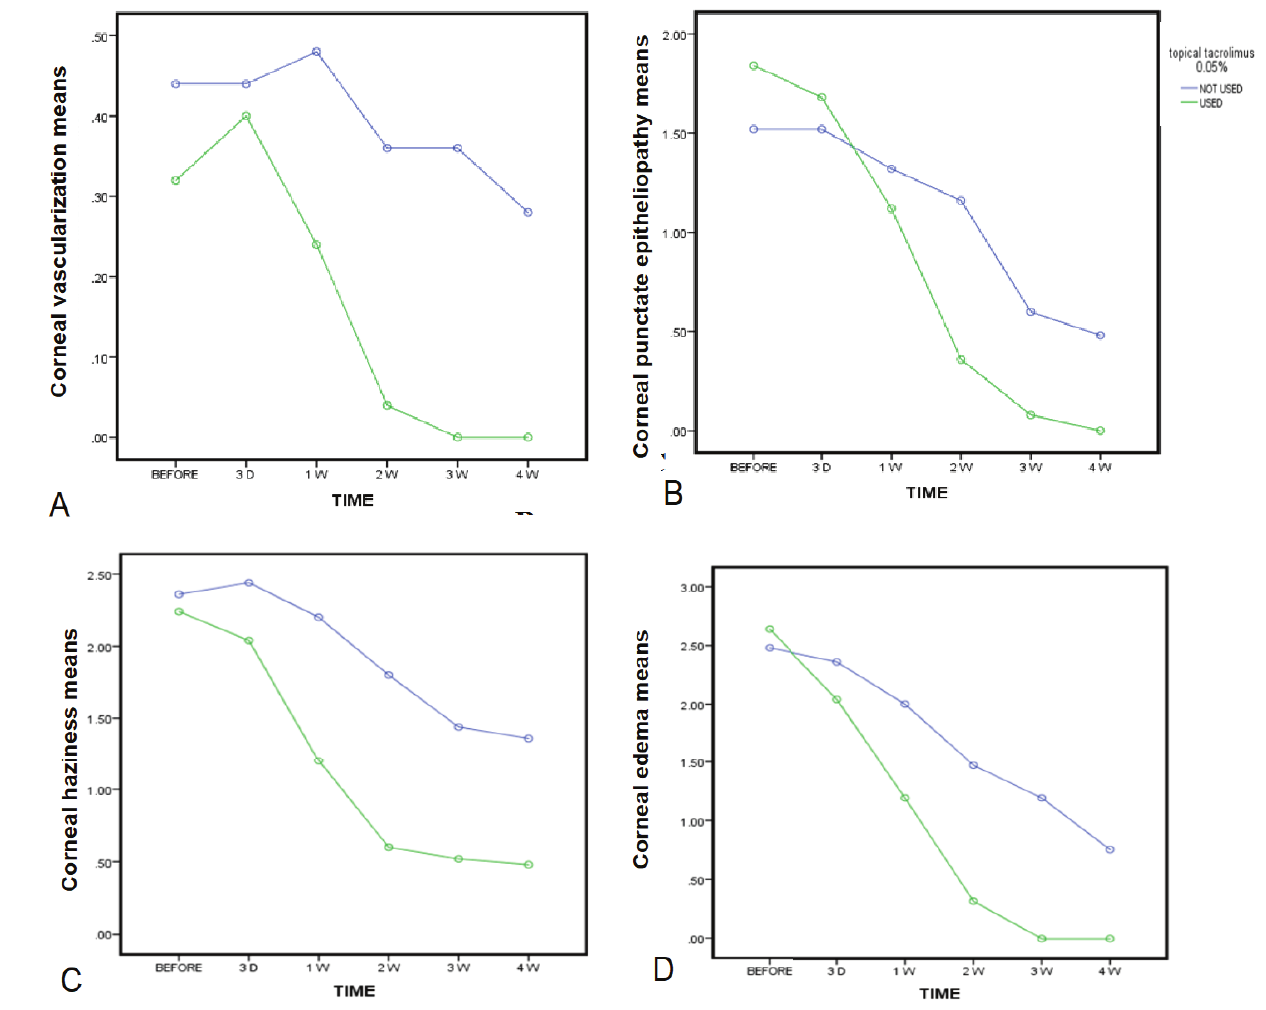
Figure 2. The trend of decrease in mean corneal vascularization (A), punctuate epitheliopathy (B), haziness (C), and edema (D) scores at baseline, 3 days, 1, 2, 3, and 4 weeks after the intervention in the case (used tacrolimus) and the control (tacrolimus was not used)